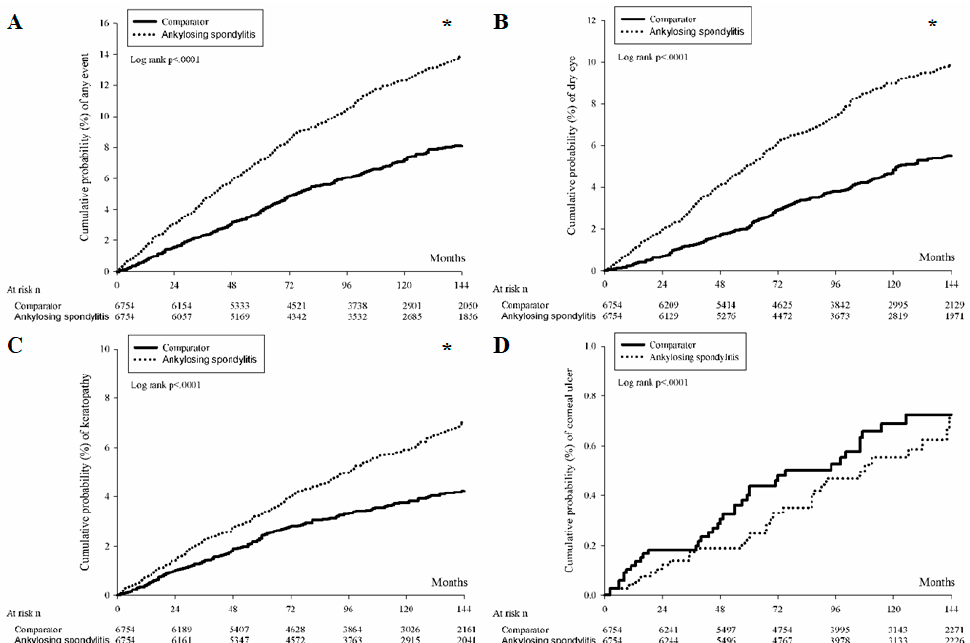
Figure 2. The cumulative incidence of external eye diseases between the ankylosing spondylitis and control groups. ( A ) The cumulative incidence of all external eye diseases. ( B ) The cumulative incidence of dry eye disease. ( C ) The cumulative incidence of superficial keratopathy. ( D ) The cumulative incidence of corneal ulcers. * denotes significant difference between groups.